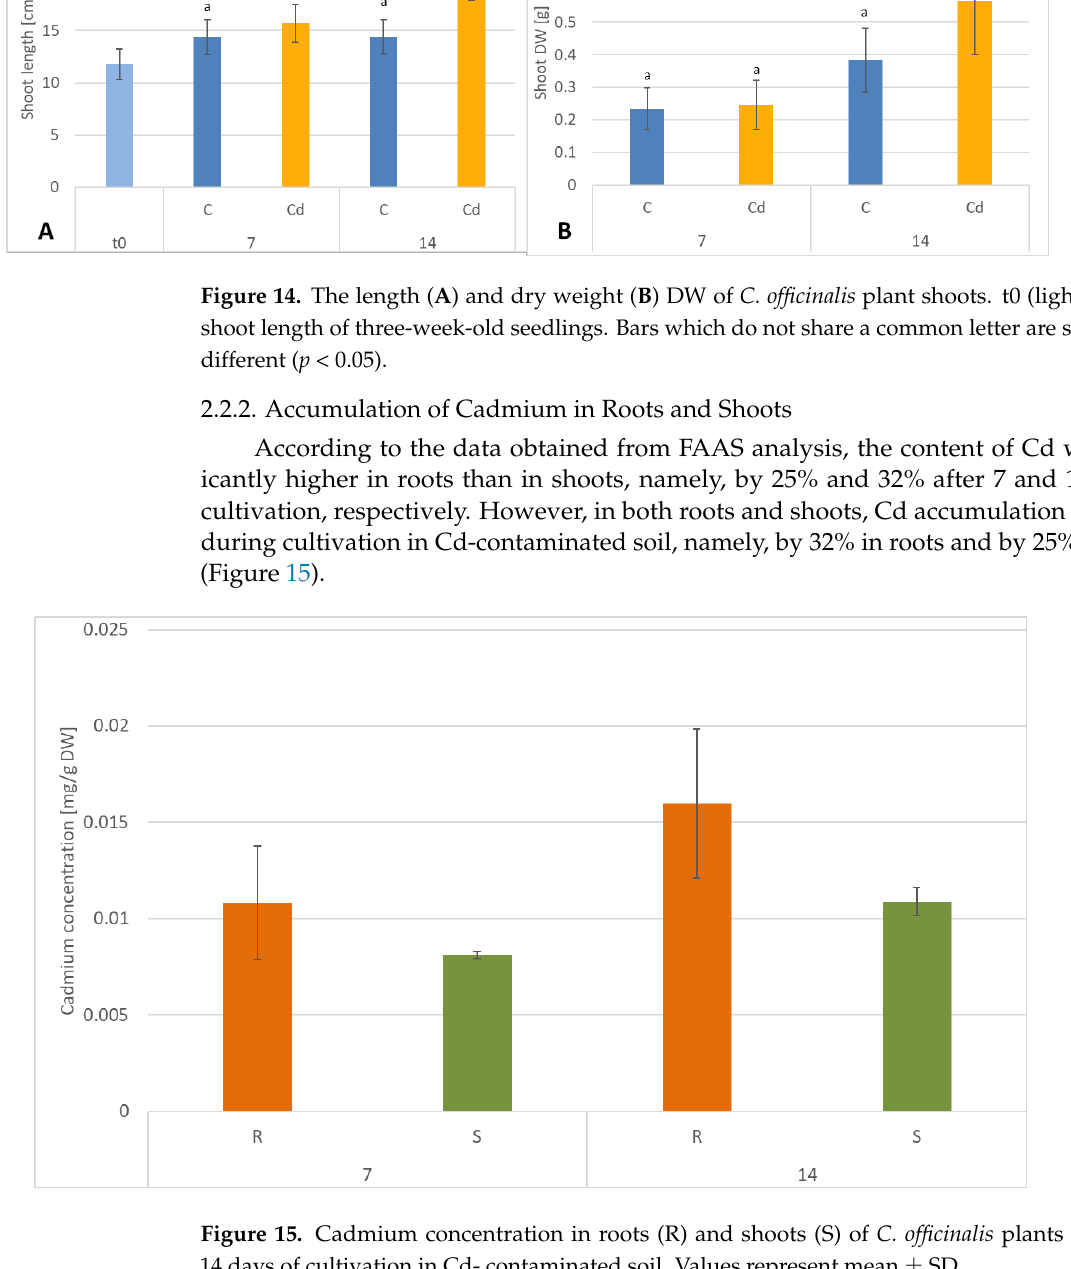
Figure 13. The length ( A ) and dry weight DW ( B ) of C. officinalis plant roots. t0 (light blue bar)- root length of three-week-old seedlings. Bars which do not share a common letter are significantly dif- ferent ( p < 0.05).